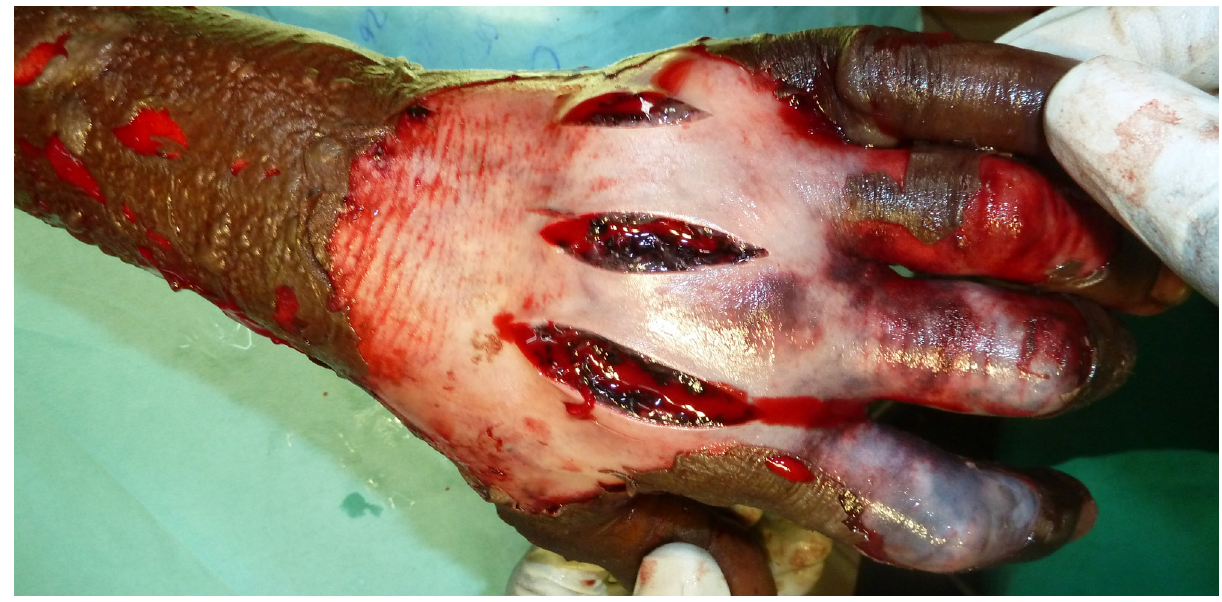
Figure 8. Fasciotomy.